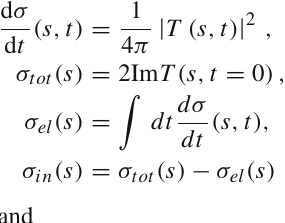
digits. For R q , R d and R qd , the values of the parameters p 0 and p 1 are given in units of femtometers (fm). For the parameters α( pp ) and α( p ¯ p ) , the parameters p 0 and p 1 are dimensionless